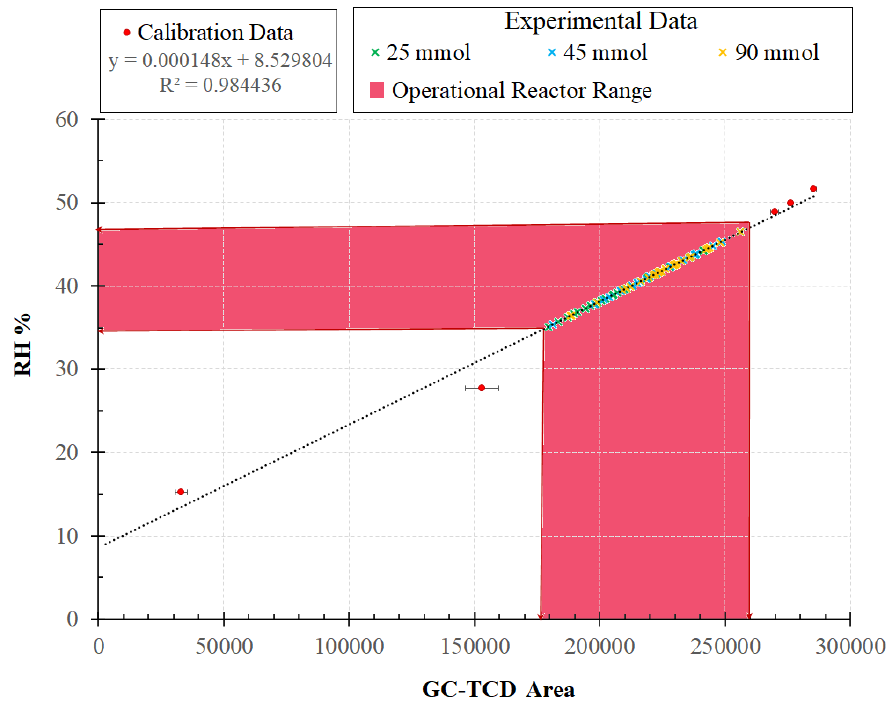
Figure A1. Spectral intensity of near-UV and visible light lamps measured by a Stellarnet Spec- trometer (EPP3000, 200–1100 nm wavelength range).